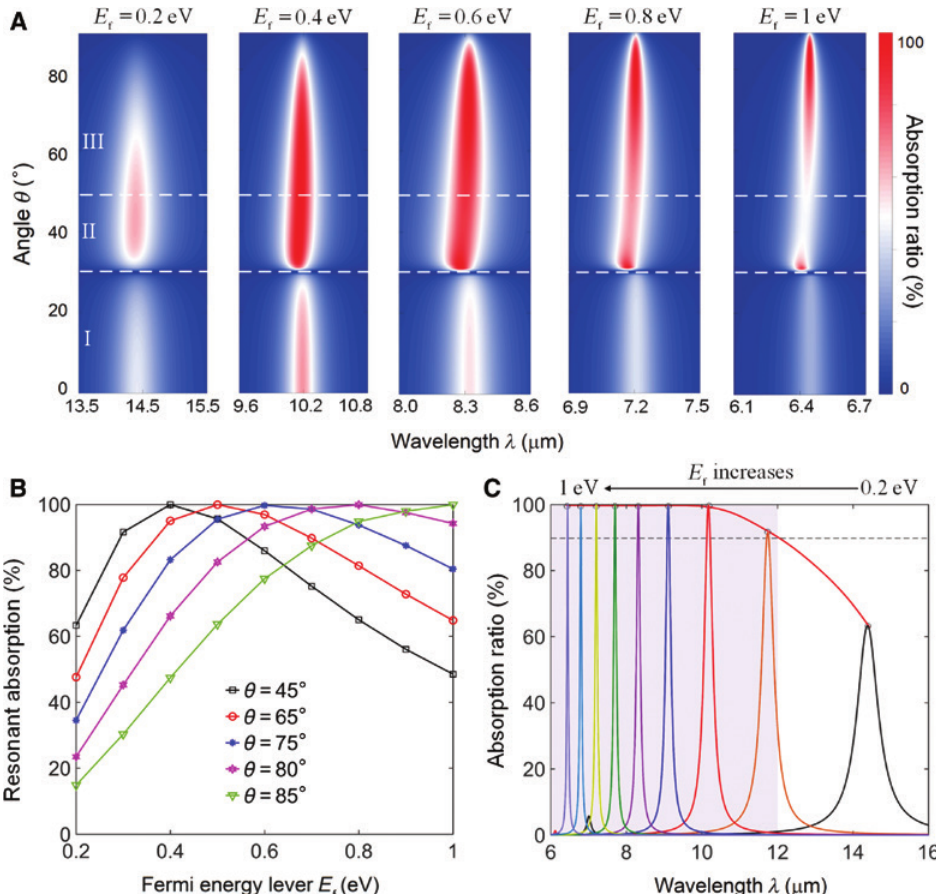
Figure 5: Wideband tunable perfect absorption by varying incident angle and graphene Fermi energy simultaneously. (A) Absorption mapping as a function of the incident angle and wavelength when E absorption as a function of Fermi energy with varying incident angles. (C) Absorption spectra with varying Fermi energy under optimized angles in the critical coupling